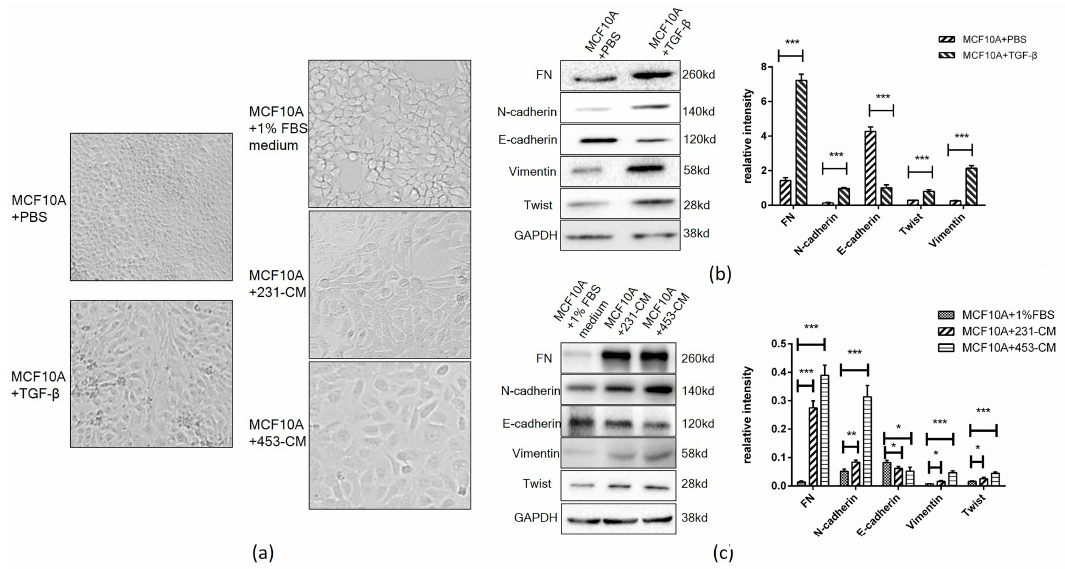
Figure 1. Cell morphology and expression of epithelial-mesenchymal transition (EMT) markers in MCF10A cells following TGF- β and conditioned medium (CM) treatment. ( a ) The morphological changes. The cells were cultured in 6-well plates and treated with CM for 24 h ( Right ). The cells cultured in DMEM (dulbecco’s modified eagle medium) with 1% fetal bovine serum (FBS) were used as control. The morphological changes of TGF- β -treated cells ( Left ) were compared with those of the CM-treated cells. The photos were taken under phase-contrast microscopy (40 × ); ( b ) Comparative expression of EMT markers in TGF- β -treated vs. PBS (phosphate buffered saline)-treated cells. Protein (10 µ g/well) was subjected to SDS-PAGE, and the expression of EMT markers N -cad, E-cad, FN, Vimentin, and TWIST1 was analyzed by Western blotting (GAPDH (reduced glyceraldehyde-phosphate dehydrogenase) as control). Histograms was used to quantify the Western blot data. *** p < 0.001; ( c ) Comparative expression of EMT markers in CM-treated vs. DMEM/1% FBS-cultured cells. Western blotting was performed as above. Histograms were used to quantify the Western blot data. * p < 0.05, ** p < 0.01, *** p < 0.001.